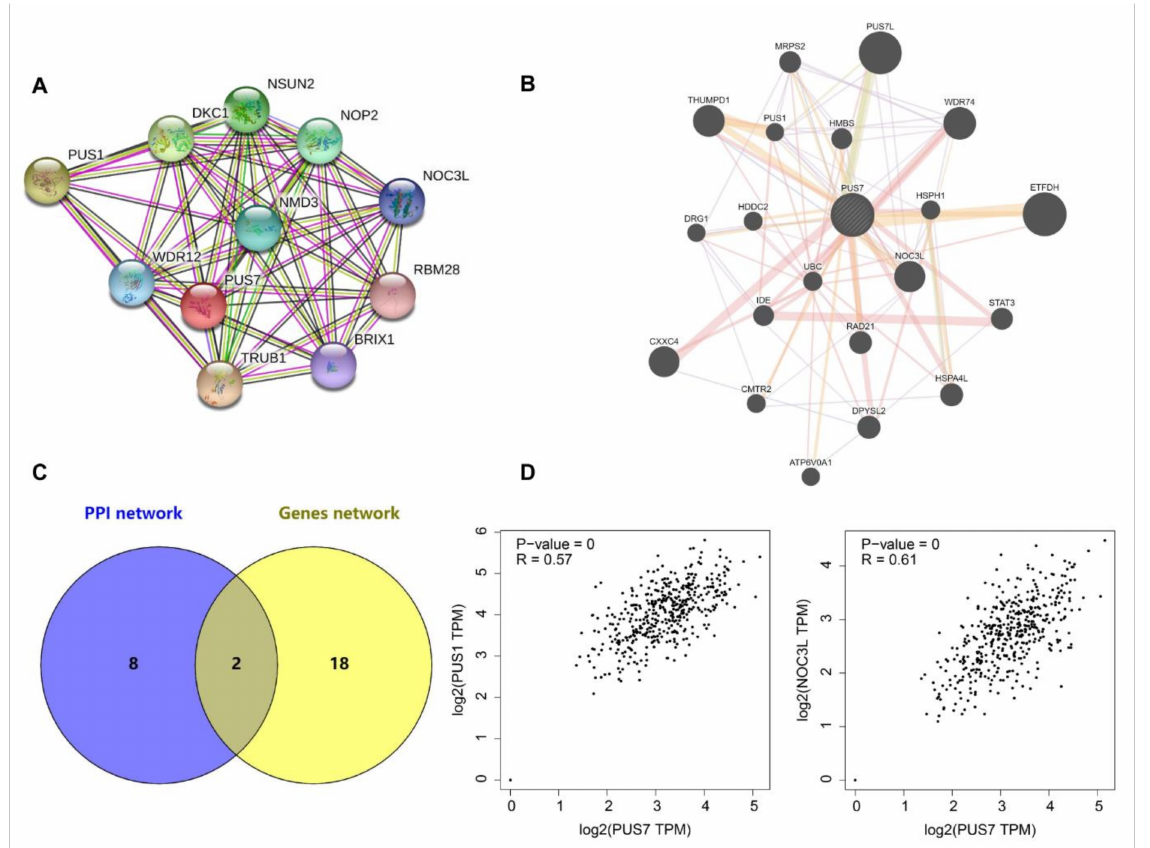
Figure 5. The interaction network and correlation of PUS7 . ( A ) The protein interaction network of PUS7. Ten proteins including NSUN2, NOP2, NOC3L, RBM28, BRIX1, TRUB1, WDR12, PUS1, DKC1, and NMD3 physically/functionally interact with PUS7. ( B ) Twenty genes named ETFDH , WDR74, THUMPD1, NOC3L, CXXC4, DPYSL2, HSPA4L, RAD21, STAT3, MRPS2, HMBS, IDE, UBC, HSPH1, HDDC2, CMTR2, ATP6V0A1, and DRG1 have physical interactions or genetic interactions, share protein domains with PUS7 , or co-express or co-localize with PUS7 . ( C ) Two genes were shared by the two networks. ( D ) The correlation analysis of PUS7 with PUS1 and NOC3L . R > 0.5 plus p < 0.05 was regarded as a significant